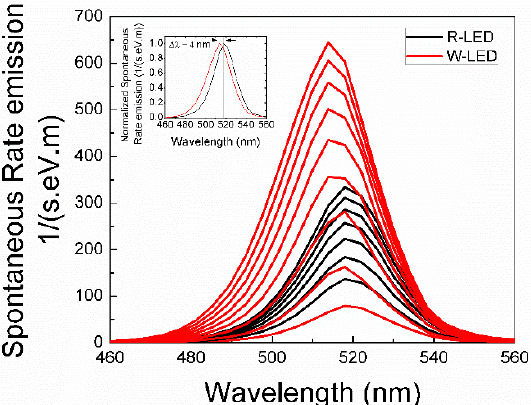
Figure 7. Emission spectra of R-LED and W-LED. The inset shows the peak wavelength comparison of the normalized emission spectra of the two devices.